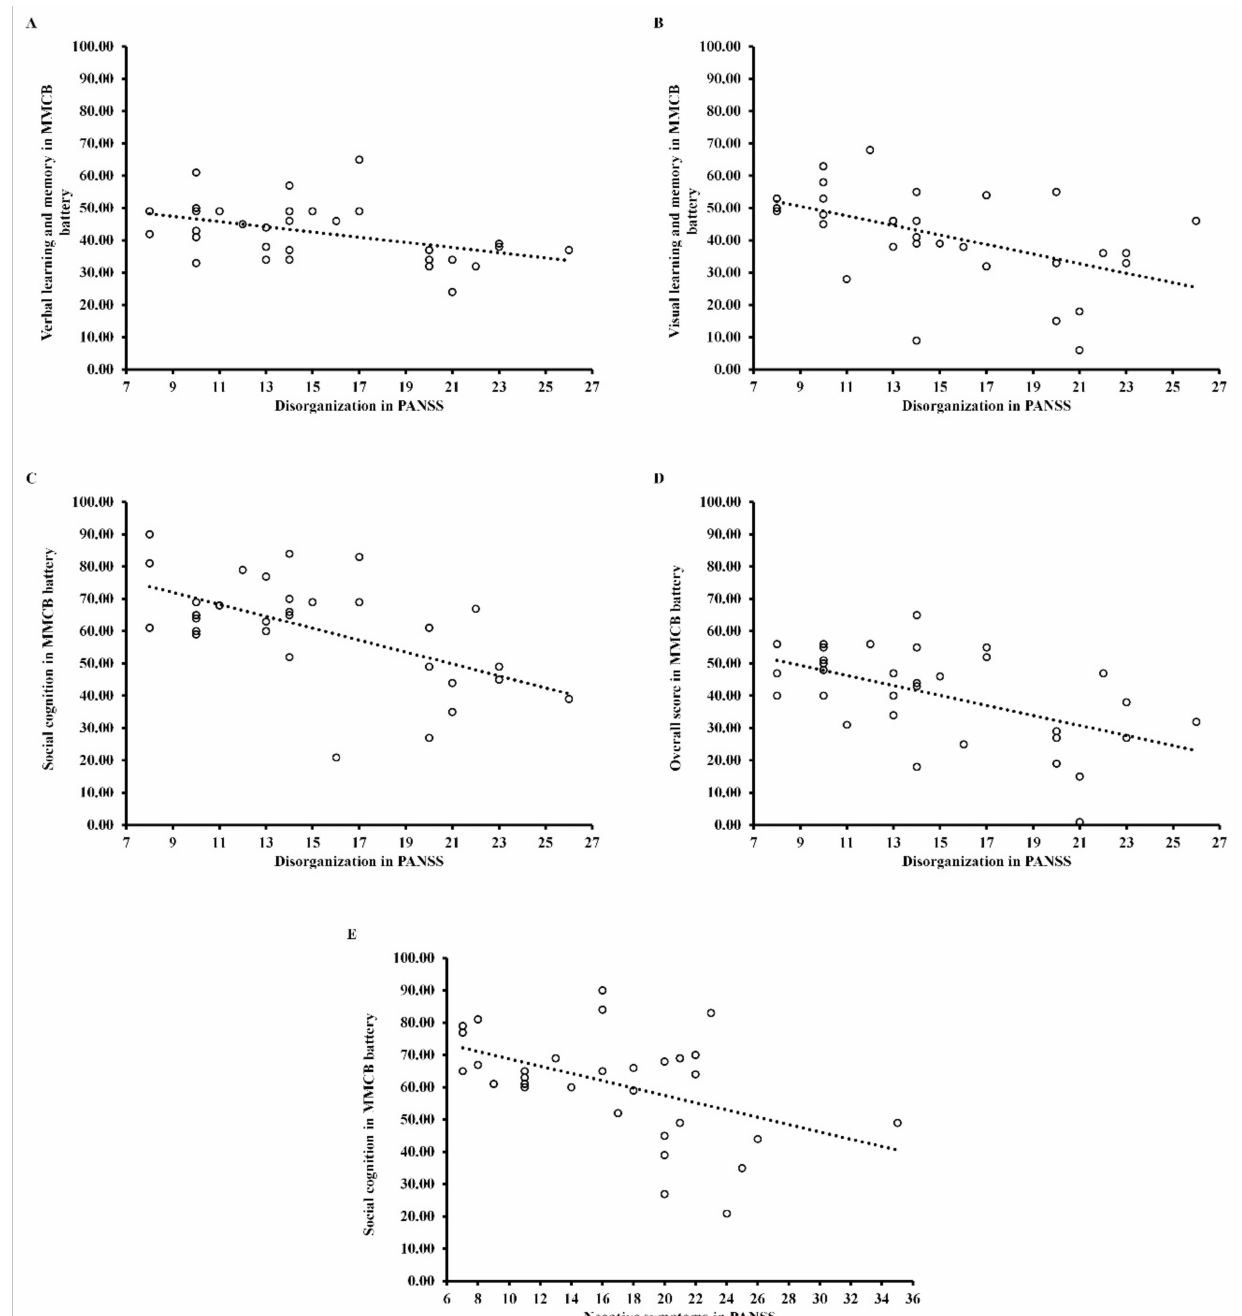
Figure 2. Scattergram for the relationship between psychopathological dimensions assessed by PANSS (( A – D ) for disorganization and ( E ) for negative symptoms) and cognitive domains measured by MMCB in First-Episode Psychosis Patients (FEP). MMCB = MATRICS Consensus Cognitive